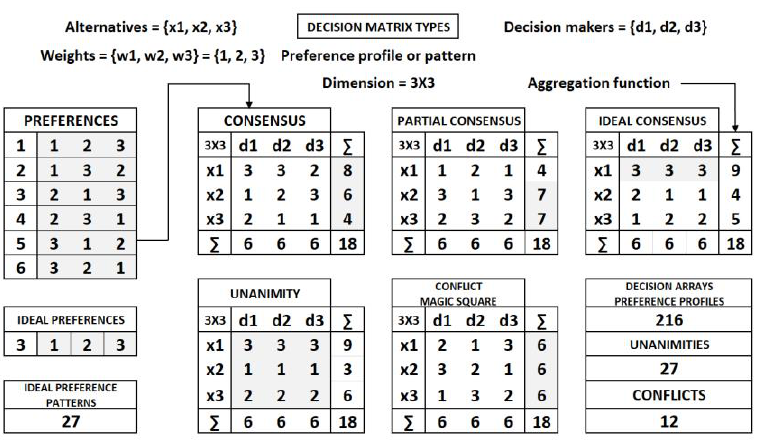
Figure 4. Example of Borda voting procedure.